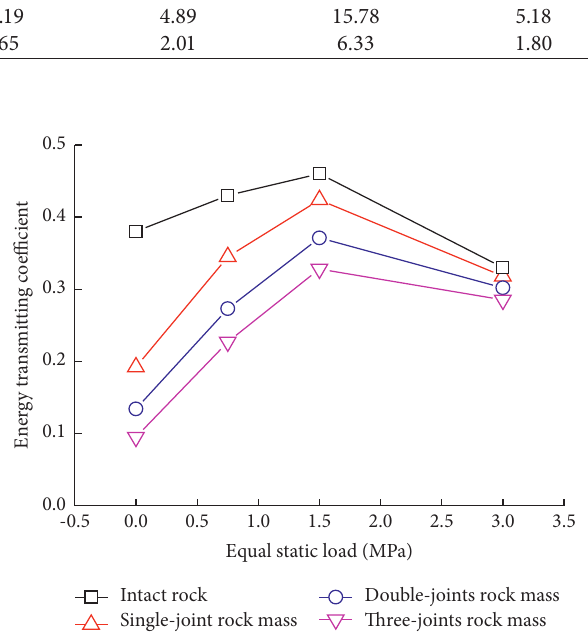
Figure 13: Energy transmitting coefficients of stress wave in intact rock and rock mass under different equal static loads.